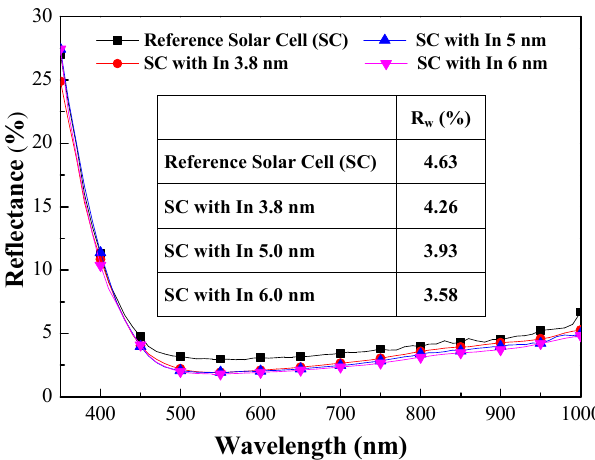
Figure 6. Optical reflectance of reference silicon solar cell (textured but without NPs) and textured cells coated with In NPs of various dimensions.